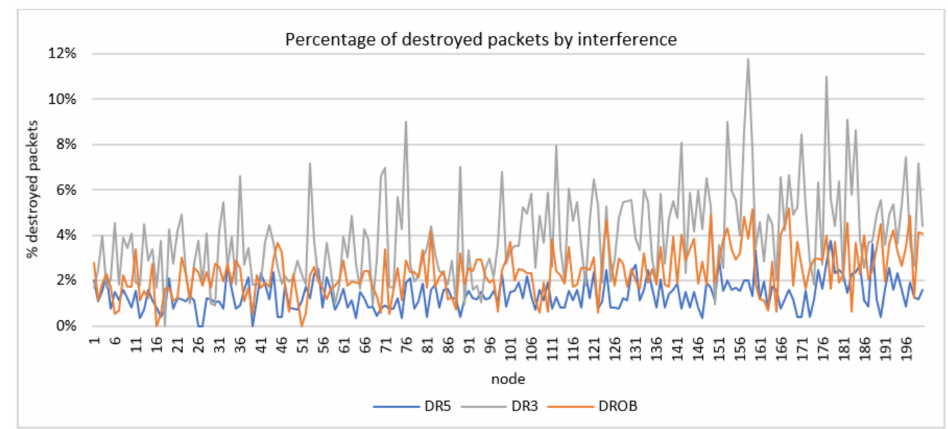
Figure 10. Destroyed packets due to interference during 24 h for all